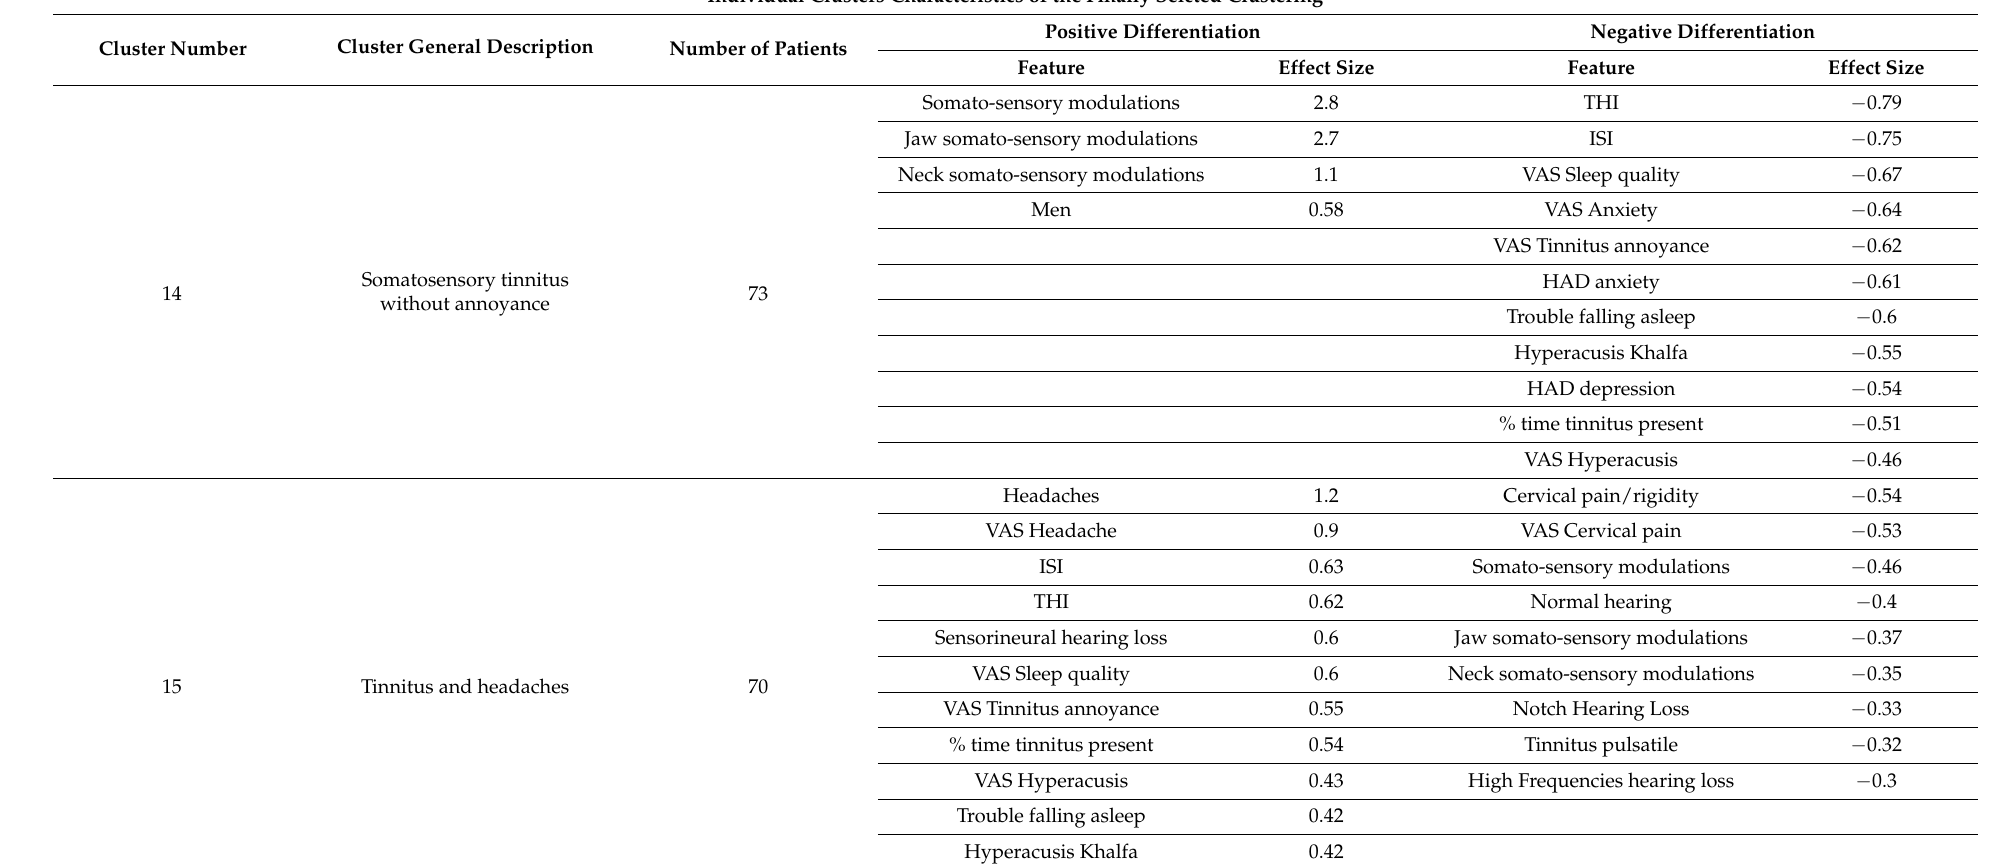
Table 7. Cont. Individual Clusters Characteristics of the Finally Selcted